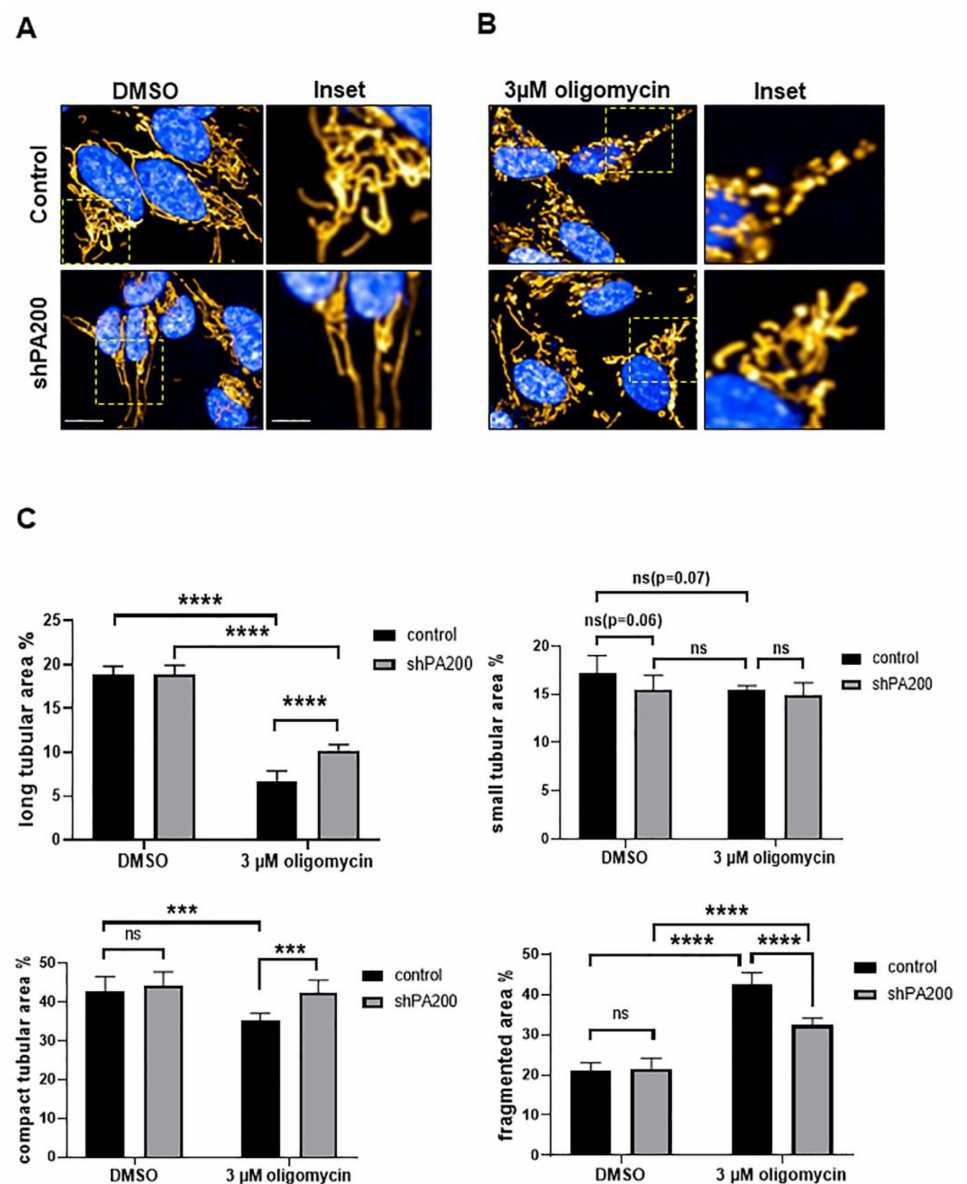
Figure 6. Reduced mitochondrial fragmentation in shPA200 cells after selective mitochondrial in- hibitor treatment. Automated confocal microscopy was performed on an Opera Phenix high-content- screening system. Image-acquisition settings were as follows: 63 × water objective (NA = 1.15), appropriate lasers and filters for Hoechst, EGFP, and Mitotracker Red CMXRos in sequential mode. ( A , B ) Representative confocal images of shPA200 and control cells stained with MitoTracker Red CMXRos after treatment with vehicle (DMSO) or 3 µ M oligomycin for 24 h (scale bar = 10 µ m, inset 2.5 µ m). ( C ) Quantification of mitochondrial classes was performed with the built-in Harmony 4.8 and PhenoLogic machine-learning software. Mitochondria were classified as long tubular area, small tubular area, compacted area, and fragmented area. Data are presented as the mean ± SD of four biological replicates. Statistical analysis was performed by two-way ANOVA (*** indicates p < 0.001, **** indicates p < 0.0001 and ns indicates not